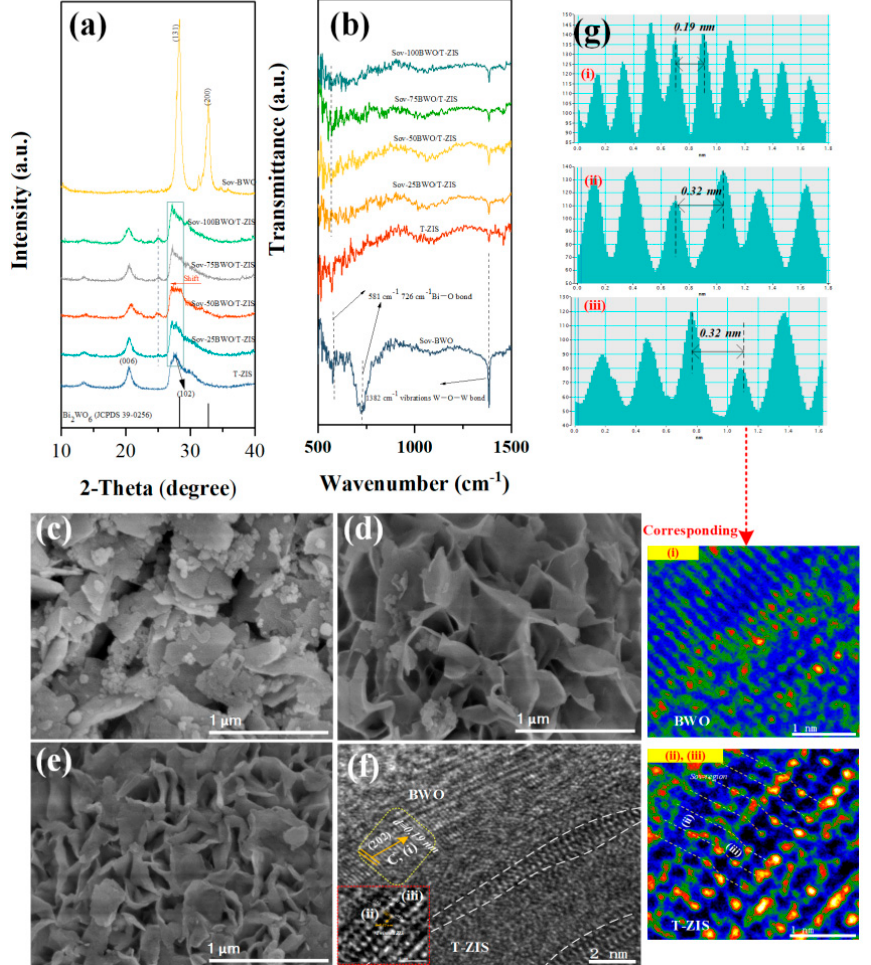
Figure 1. ( a ) XRD patterns and ( b ) FT-IR spectra. FE-SEM images of ( c ) Sov − BWO, ( d ) T − ZIS, ( e ) Sov − 50BWO/T − ZIS; ( f ) HRTEM images of Sov − 50BWO/T − ZIS; ( g ) corresponding false-color image in vacancies-rich (202) lattice plane of Sov − BWO and the (102) lattice plane corresponding to twin crystal T − ZIS. The measured lattice planes ((i), (ii), (iii)) are chosen from region ( f ).